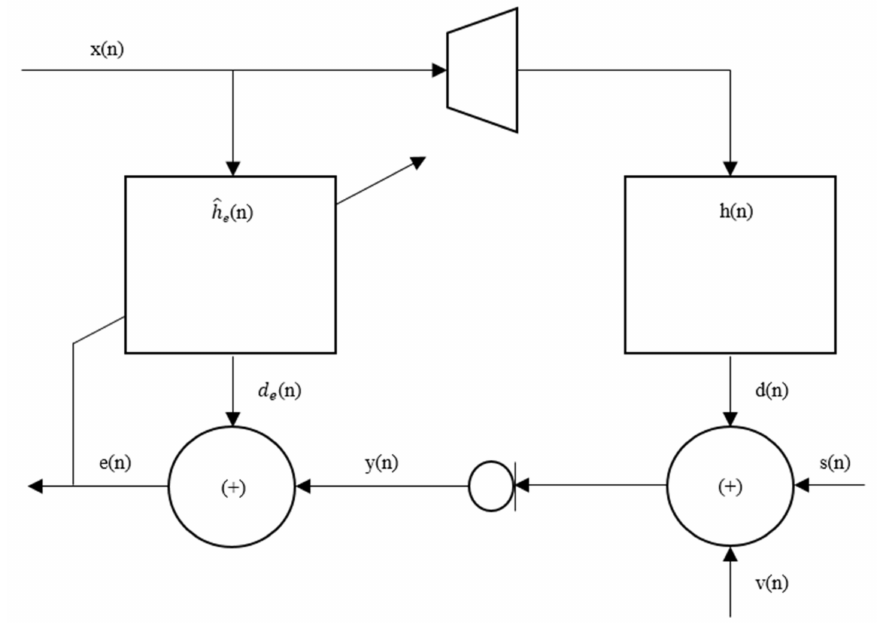
Figure 5. Block diagram of the acoustic echo cancellation